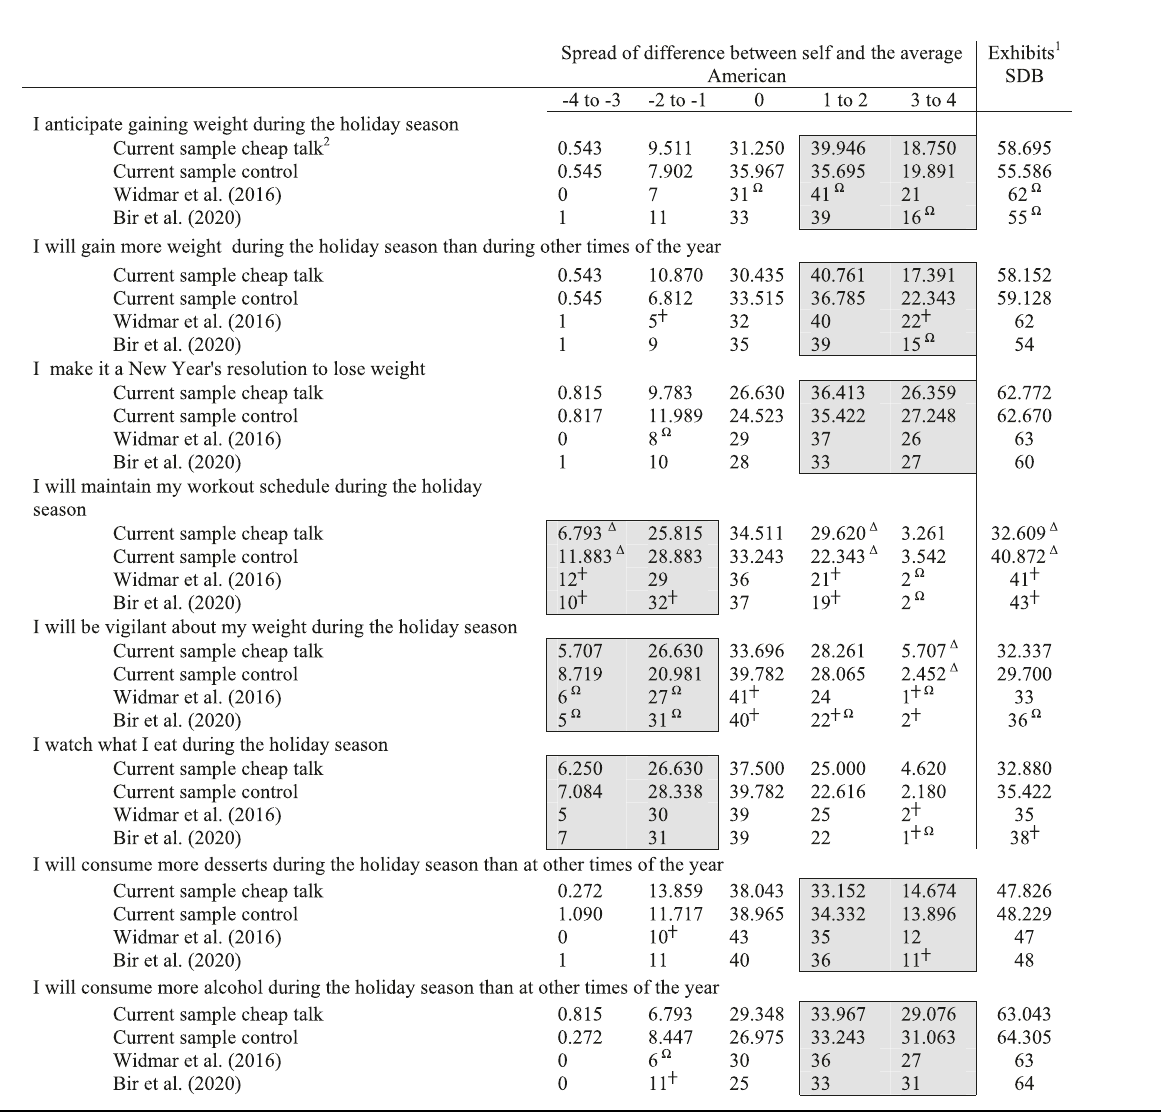
Table 5 Comparison of percentage of respondents with SDB scores between current sample and previous publications, box indicates direction of